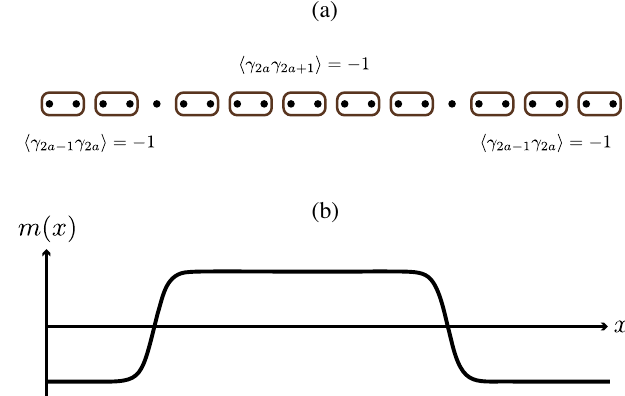
γ − 1 . Domain a a þ 1 i ¼